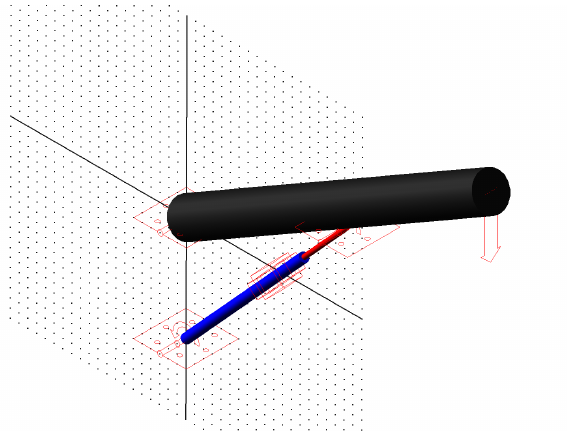
Figure 7. ADAMS model of mechanical